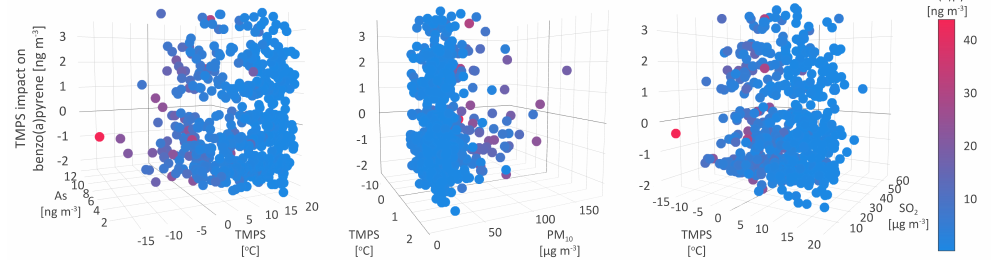
Figure 7. Temperature at surface impact on